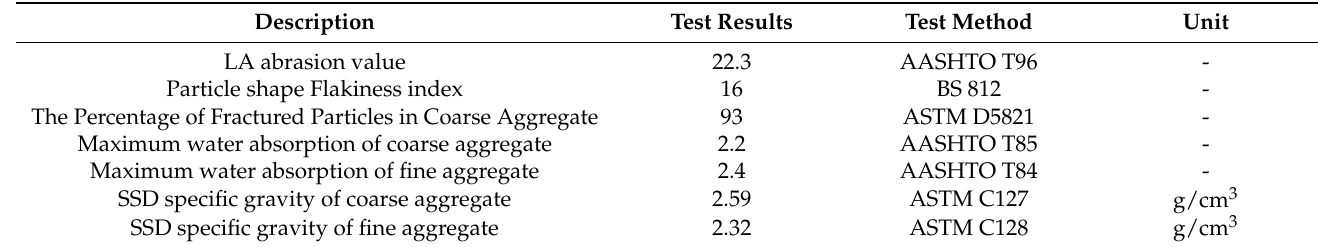
Figure 1. The Gradation of Aggregates in the WMA sample. Table 3. The Properties of the Aggregate.